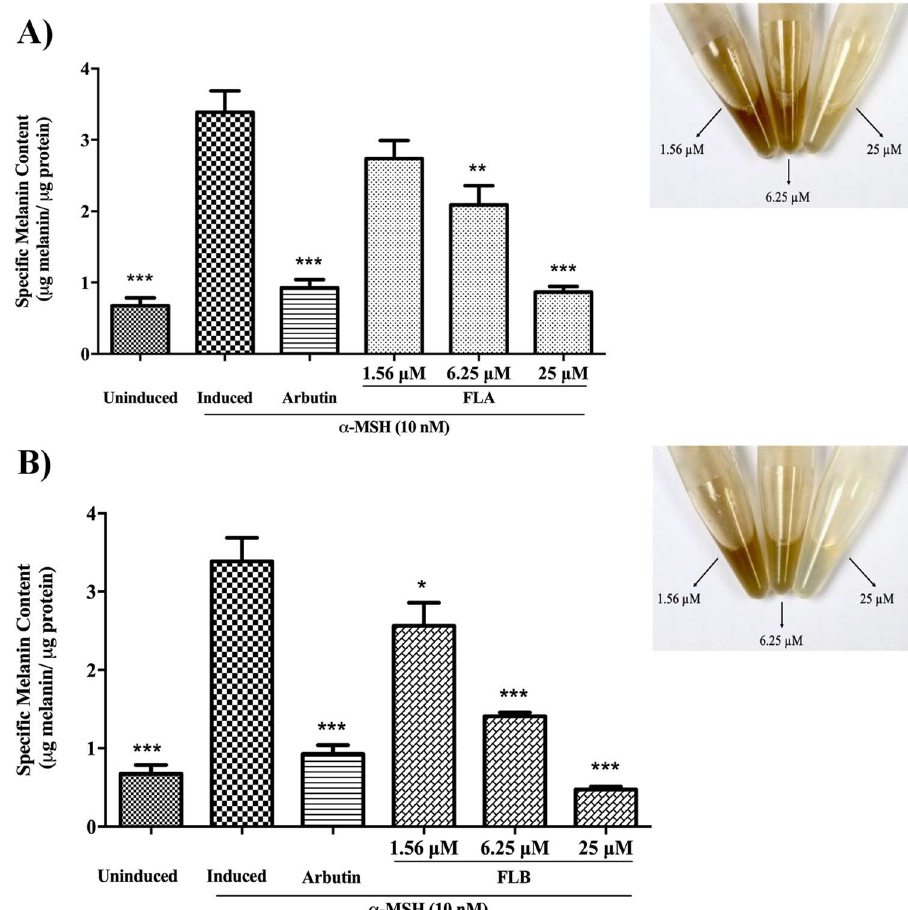
Figure 2. Effect of chalcone derivatives on melanin production of α-MSH-induced B16/F10 cells. Cellular melanin content after treated with ( A ) FLA and ( B ) FLB. Both compounds were tested at different concentrations (25, 6.25 and 1.56 µM) and incubated for 72 h. Arbutin (50 µM) was used as positive control. All values are the mean ± S.E.M. of three independent experiments. ** p < 0.01 and *** p < 0.01 were considered significantly different to α-MSH-induced control group.